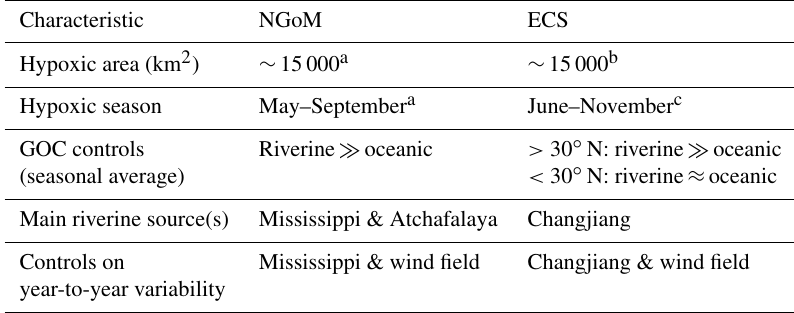
Table 2. Comparison of hypoxia in the northern Gulf of Mexico (NGoM) and the East China Sea (ECS).